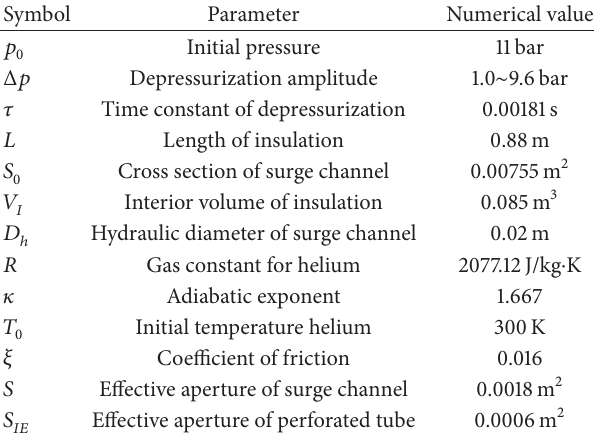
Table 1: Input parameters for numerical